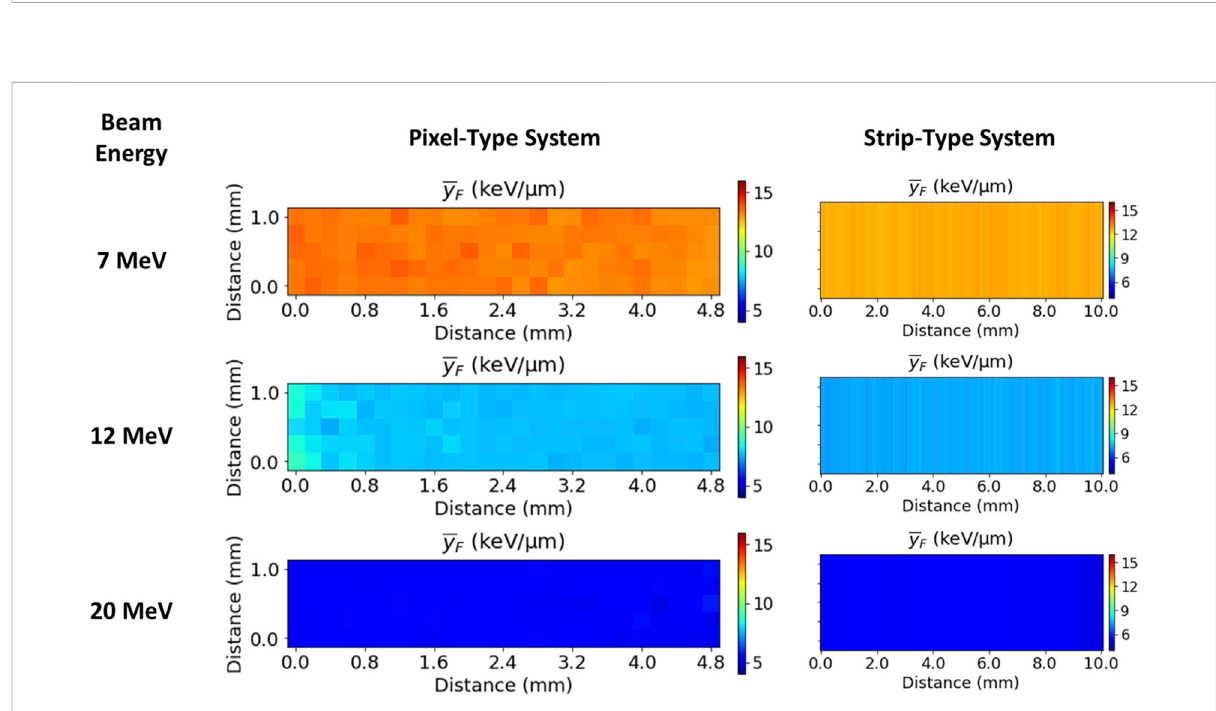
FIGURE 10 Maps of the frequency-mean lineal energy (cid:1) y F values obtained with the pixel (left, 2D) and the strip (right, 1D) systems.